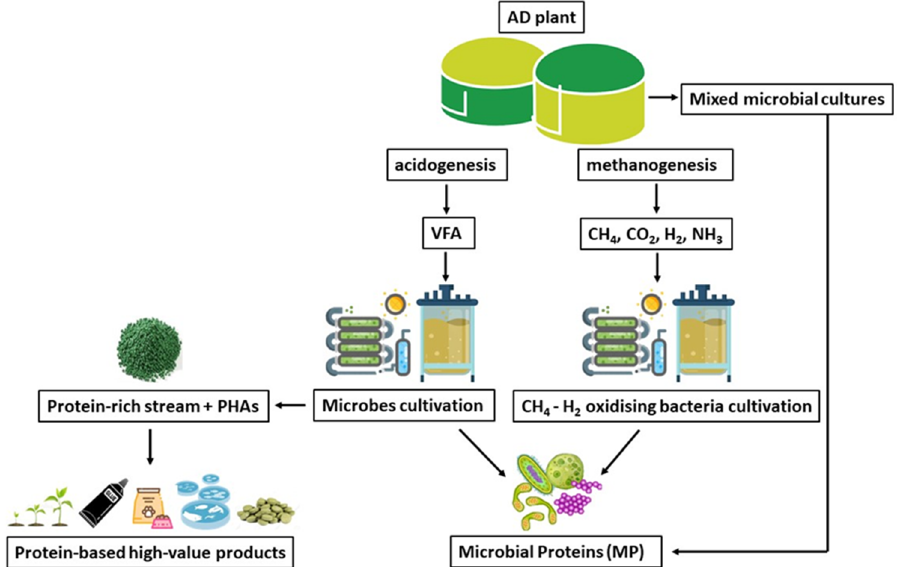
Figure 2. Schematic representation of the routes through which proteins can be recovered from AD plants. AD plants.